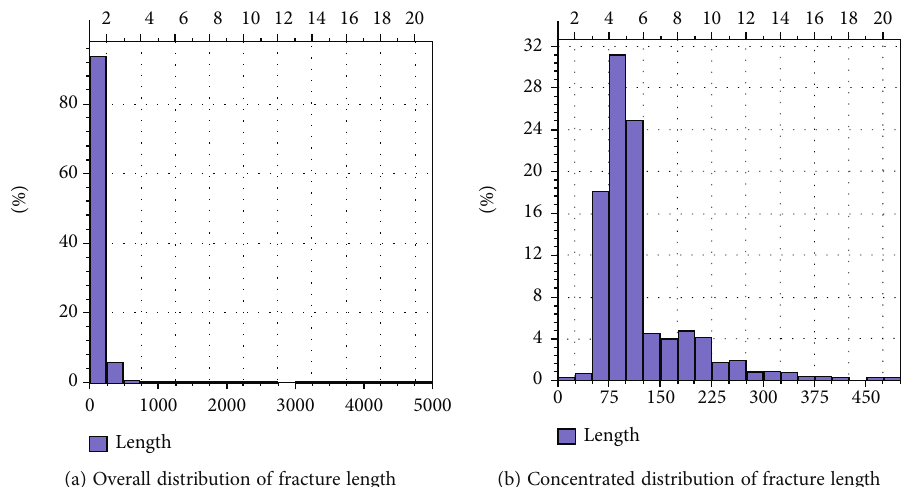
Figure 14: Histogram of fracture length